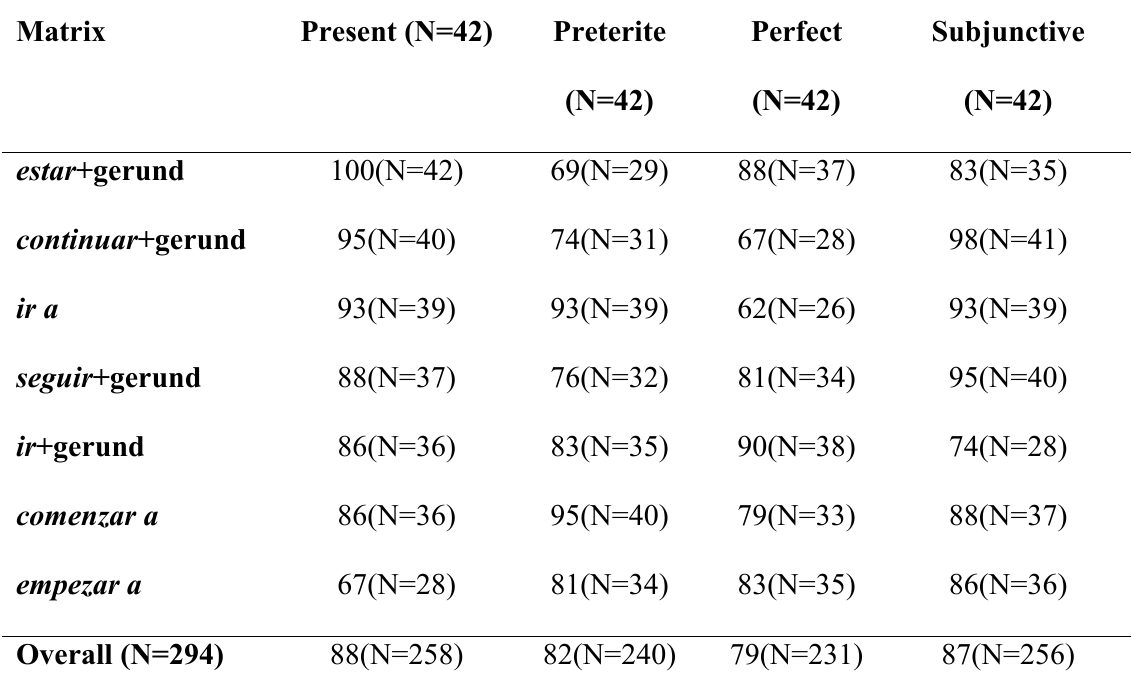
Table 3 . % acceptability of CC across all matrix verbs tested against all internal variables in the 2013